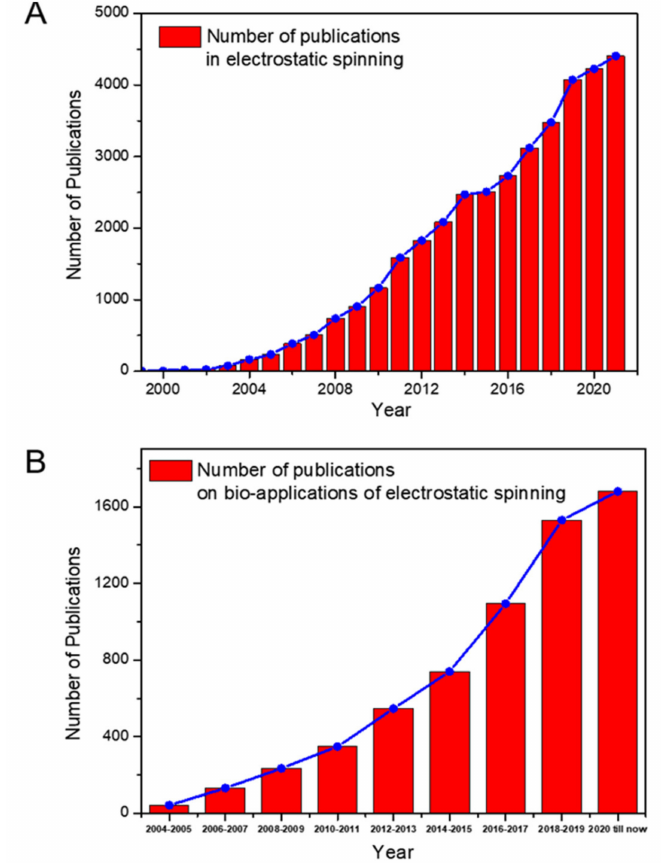
Figure 1. Number of publications on ( A ) electrostatic spinning and ( B ) bio-applications of electrostatic spinning indexed by Web of